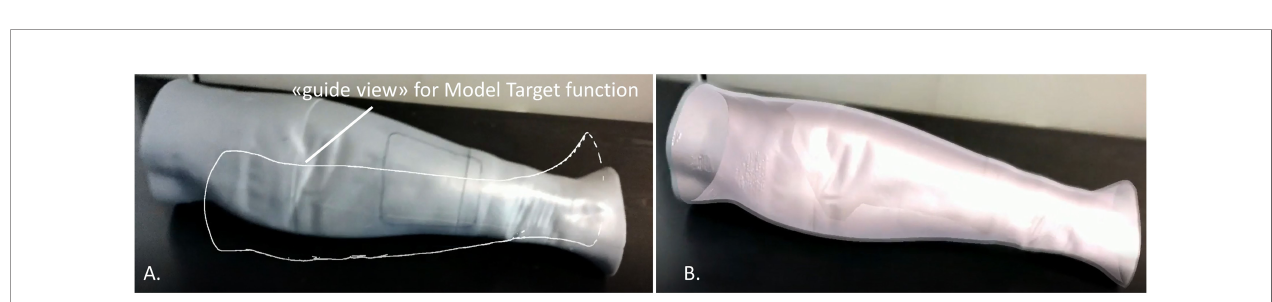
FIGURE 3 | Example of the “ guide view ” in the Model Target function (A) , showing an approximation of the object shape used for tracking the phantom leg and matching to it the virtual content (B)